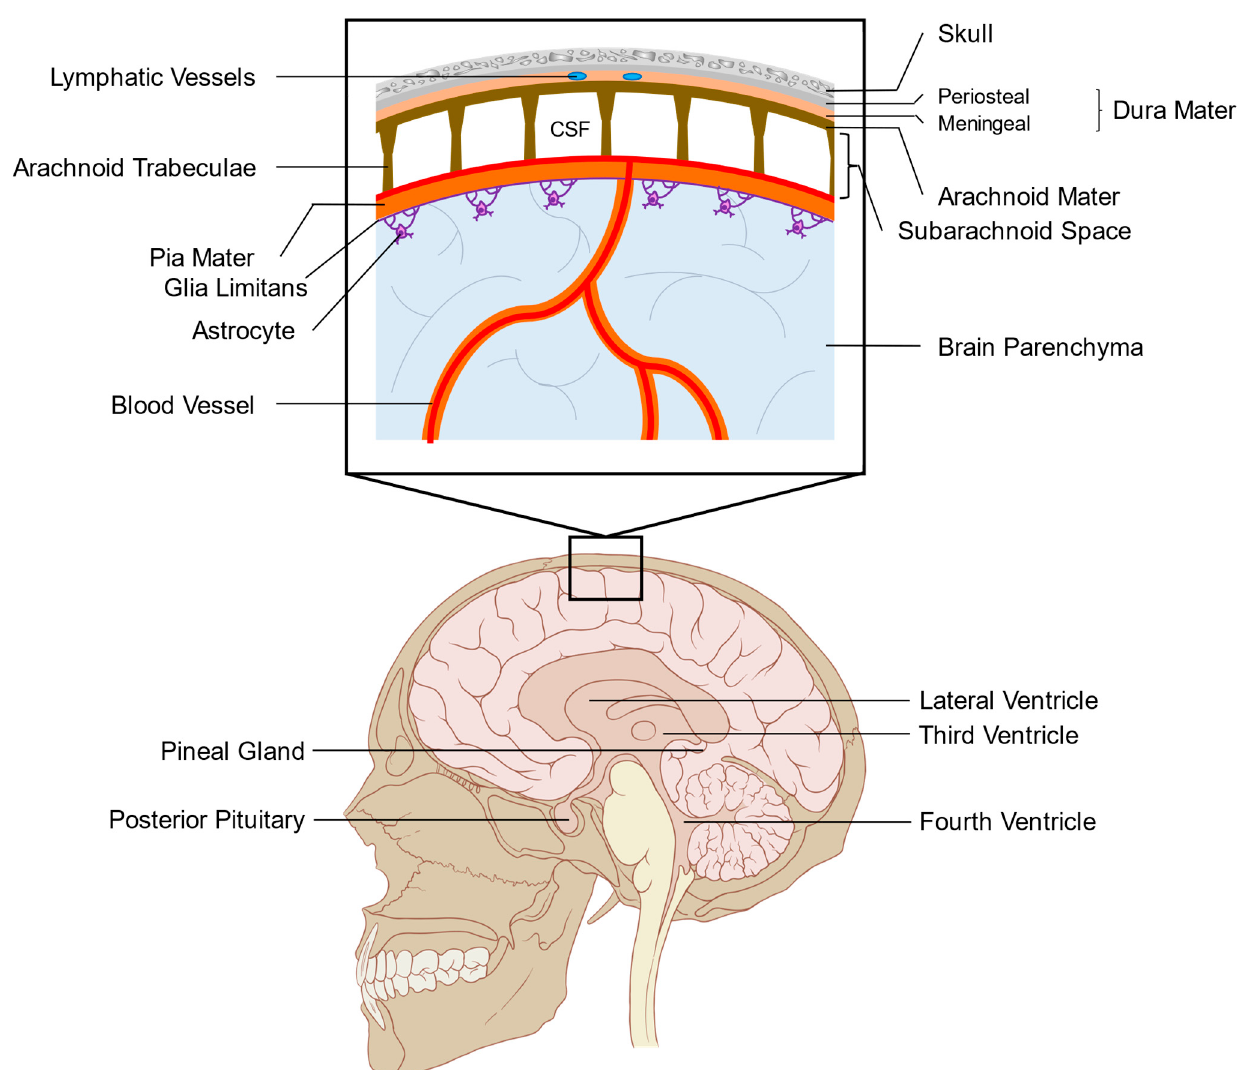
Figure 1. Anatomy of the leptomeninges and surrounding structures. Leptomeningeal-metastatic cancer cells exist in the subarachnoid space, between the arachnoid and pia mater, deep in the dura mater and skull. Cancer cells may be adherent to the walls of the subarachnoid structures or survive in suspension in the cerebrospinal fluid (CSF). CSF is created in the choroid plexus of the lateral and fourth ventricles and flows through the ventricular system into the subarachnoid space. The subarachnoid space is separated from the brain parenchyma by the glia limitans consisting of astrocytic foot processes. The leptomeninges surrounds the entire brain and spinal cord, with notable exceptions including circumventricular organs such as the pineal gland and posterior pituitary.